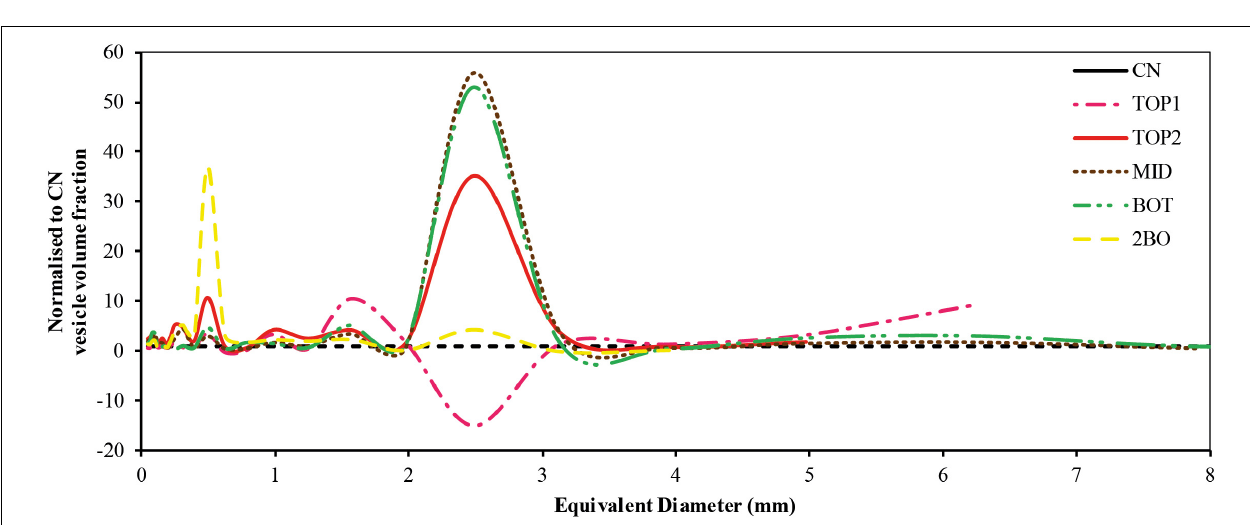
FIGURE 5 | Density-derived porosity as a function of depth in the mold (median value with range for each sample). The vertical-dashed line defines the porosity-defined limit between S-Type and P-Type p¯ahoehoe lava, as taken from data in Cashman et al. (1994), Harris and Rowland (2015), and Harris et al. (2017).